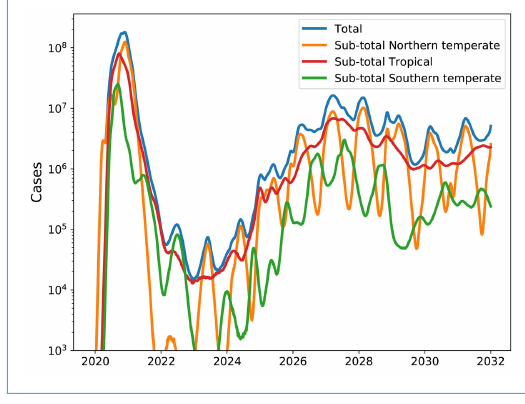
Figure 5: Transition to an endemic seasonal virus. If previously in- fected individuals can be reinfected after some time, as for exam- ple by seasonal influenza virus, SARS-CoV-2 could develop into a seasonal CoV that returns every winter. This would typically hap- pen at much lower prevalence than peak pandemic levels. These simulations assume reinfection on average every 10